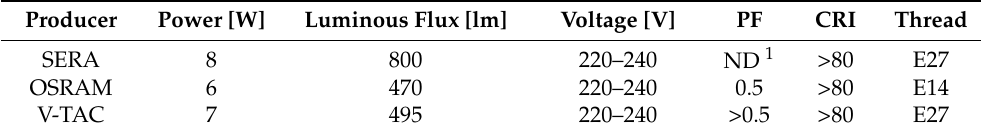
Table 1. Declared parameters of low-power light sources.